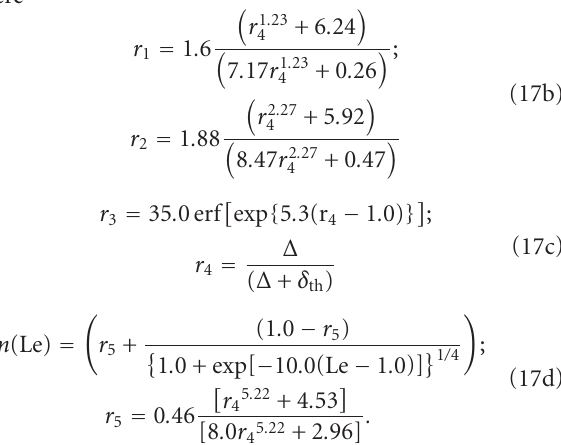
Figure 6: Variations of the model parameters β 1 ( (cid:13) ), β 2 ( (cid:2) ), β 3 ( (cid:3) ), β 4 / Σ gen (down-pointing triangle), β 5 (+), a Σ ( ∗ ), and c ∗ ( × ) with Δ for: (a) Le = 0 . 34; (b) Le = 0 . 6; (c) Le = 0 . 8; (d) Le = 1 . 0; (e) Le = 1 . 2. sub-grid fluctuations of D are taken to scale with S L / Σ gen .